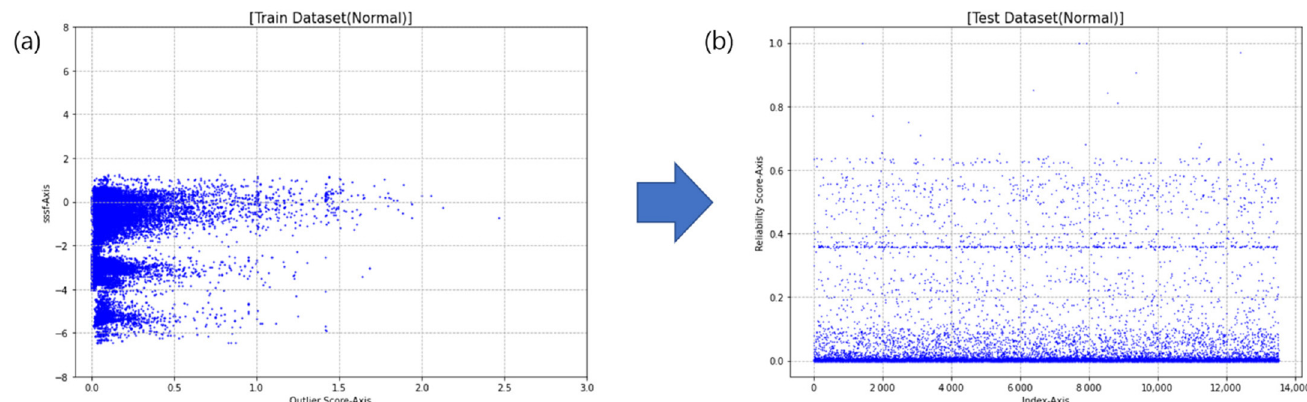
Figure 7. Process of calculating the reliability score of the test dataset with the training dataset of IDS dataset: ( a ) SSSF/outlier score distribution calculated from the training dataset labeled normal; ( b ) reliability score distribution of the data predicted as normal in the test dataset.